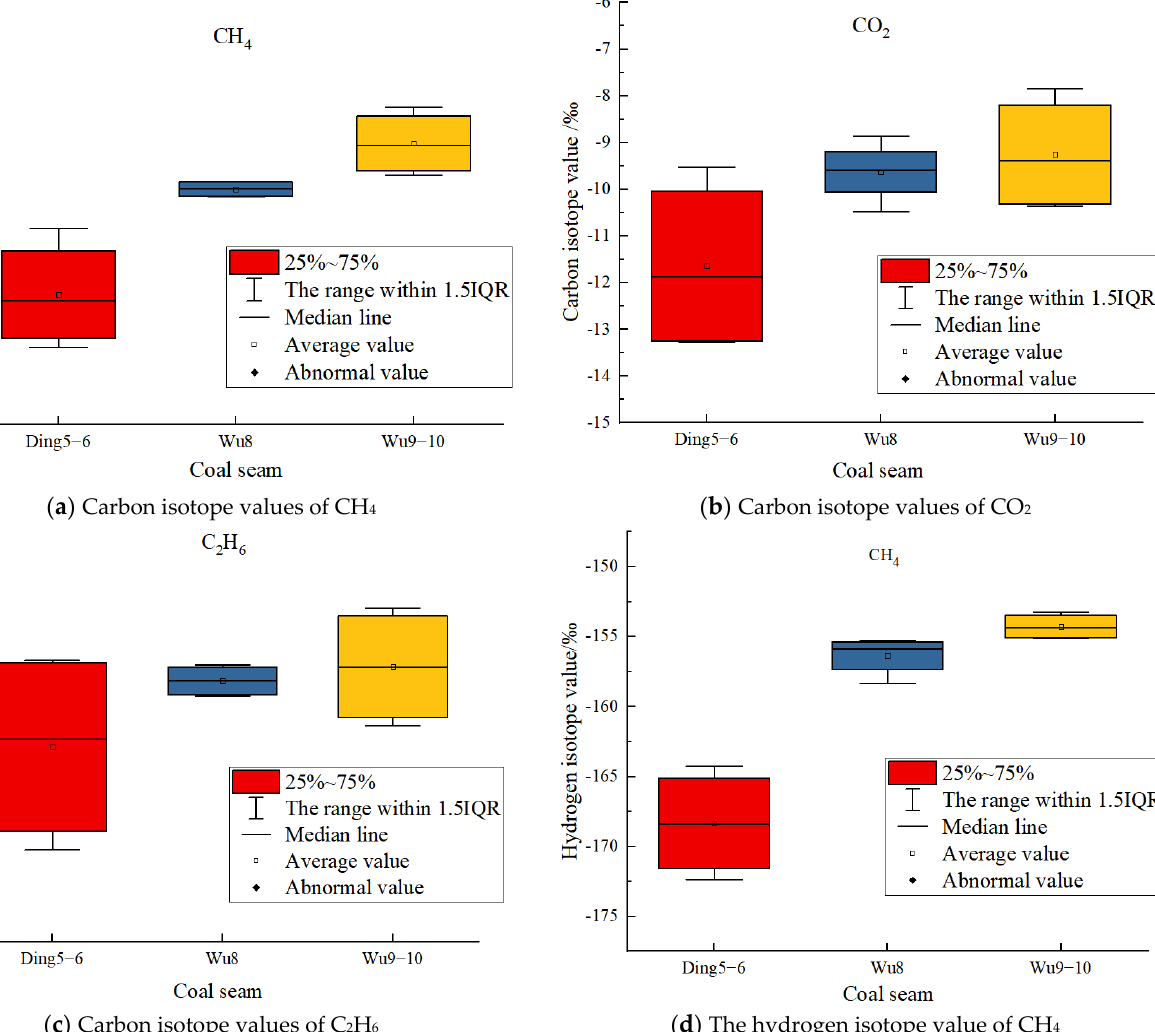
Figure 4. Box diagram of hydrocarbon isotope value distribution of gas in each coal seam.